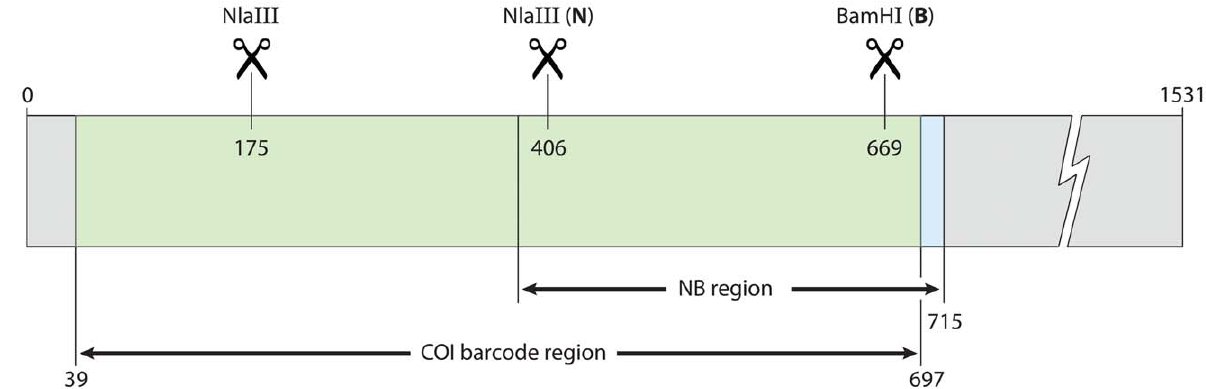
Figure 2. Barcode region of the cytochrome oxidase I (COI) gene. The barcode region spans 658 base pairs near to the 5 9 end of the COI gene and includes the two diagnostic restriction enzyme sites of the ‘NB system’ of Bogdanowicz et al. [24], referred to as N and B. An additional monomorphic NlaIII site is found in the 5 9 region of the gene fragment and therefore a NlaIII enzyme digest of the barcode region would result in two (N 2 ) or three (N + ) bands (instead of 1 or 2 bands).